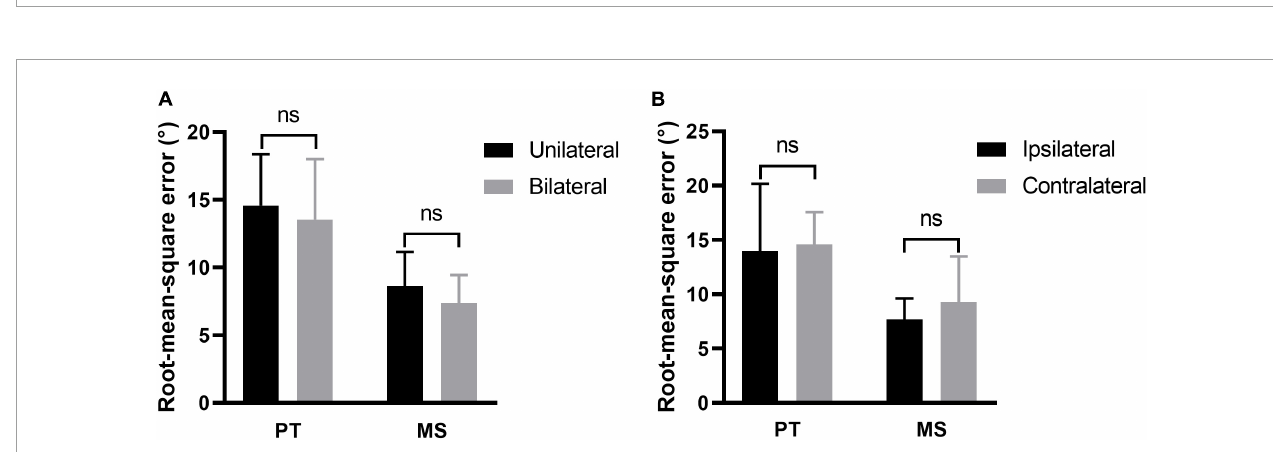
FIGURE5 Effect of tinnitus side on sound localization. (A) The sound localization behavior of participants with unilateral and bilateral tinnitus. (B) The ability to localize sound originating from the same side of tinnitus and those from the opposite side of tinnitus. PT, pure tone; MS, monosyllable. Ns, not